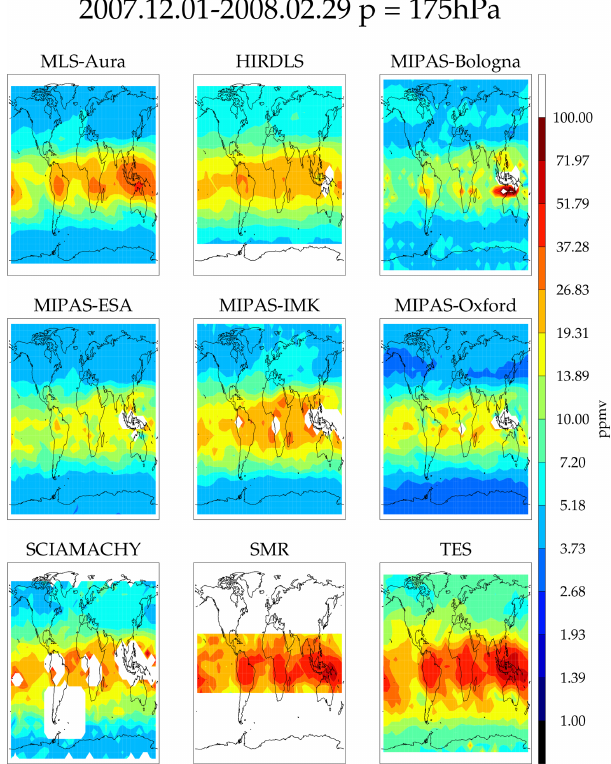
Figure 22. Gridded maps at 175hPa generated from nine instru- ments. The time period is December 2007–February